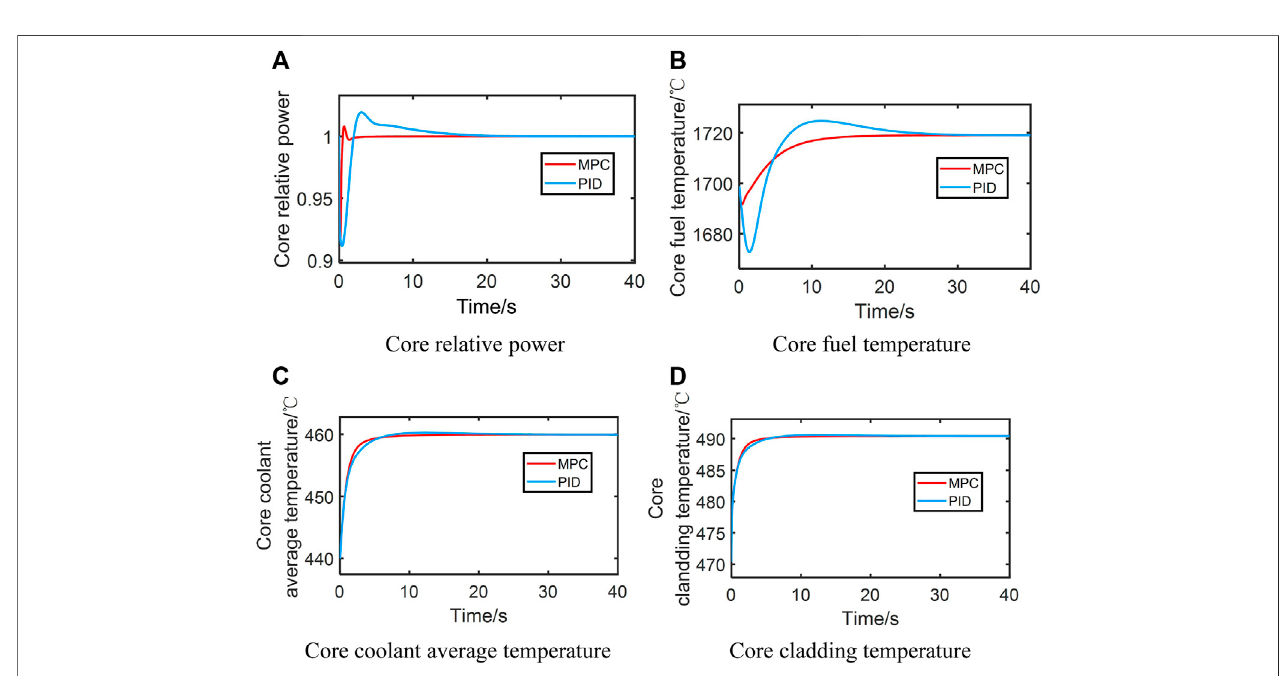
FIGURE 5 | Response of an LFR core power control system after introducing a 5% step down of core coolant inlet temperature. Bode diagram are drawn. As shown in Figures 6 , 7 , the Nyquist of characteristic roots outside the unit circle is zero. According diagram and Pole-Zero Map are drawn to judge the absolute to the Nyquist criterion, both closed-loop systems are stable. stability of the core power control system. According to the Nyquist diagram, the number of times that the Nyquist curve bypasses point ( − 1,0) counterclockwise is zero, and the number